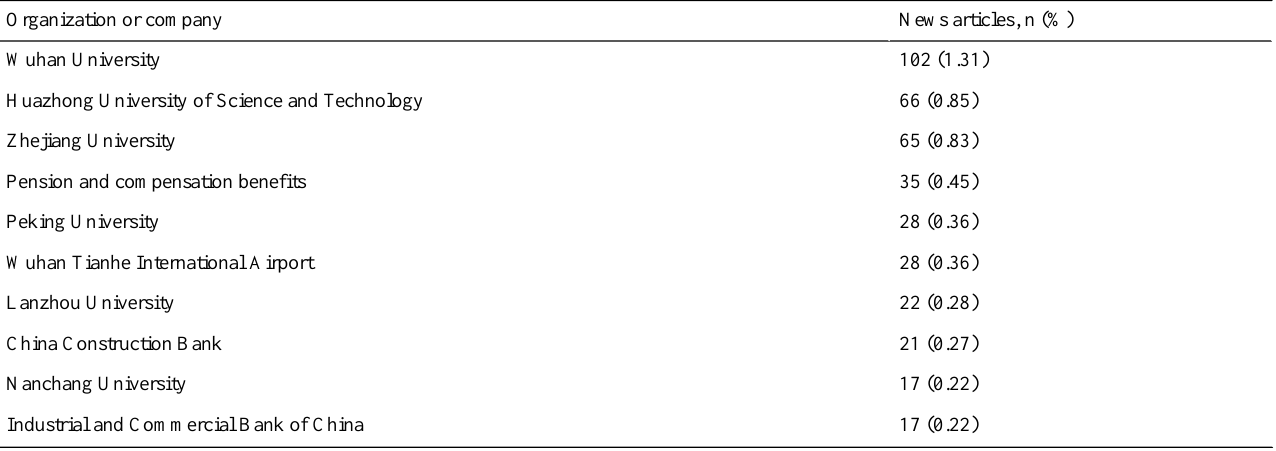
Table 3. Organizations and companies mentioned in news reports